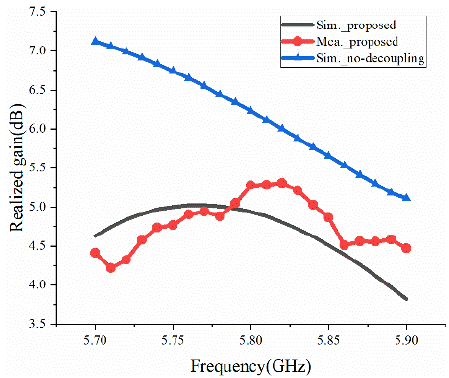
Figure 9. Realize gain comparisons.